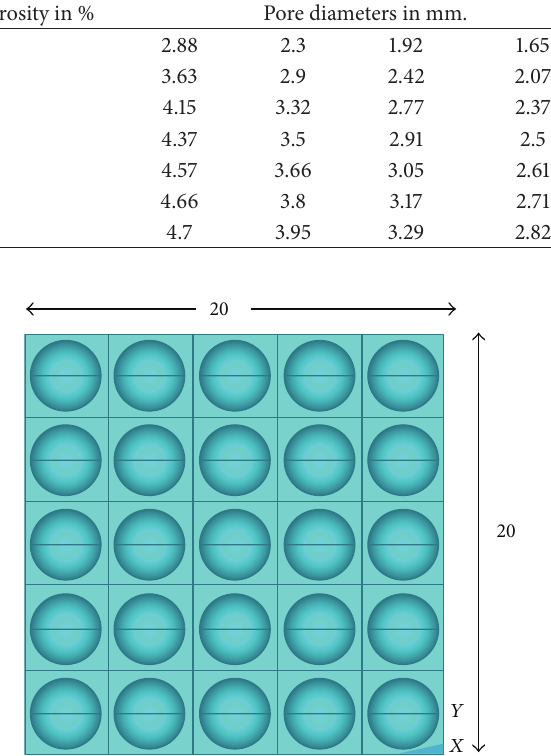
Figure 1: Pore distribution pattern (square